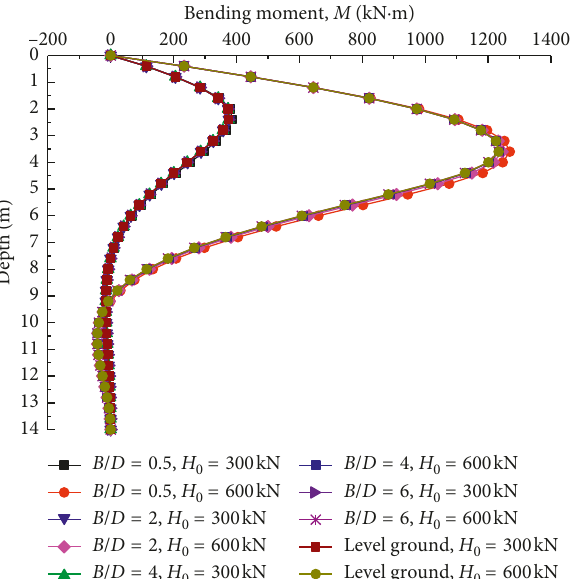
Figure 20: Bending moment variation along the depth of pile for θ 50 ° for different slope angle. (cid:31)